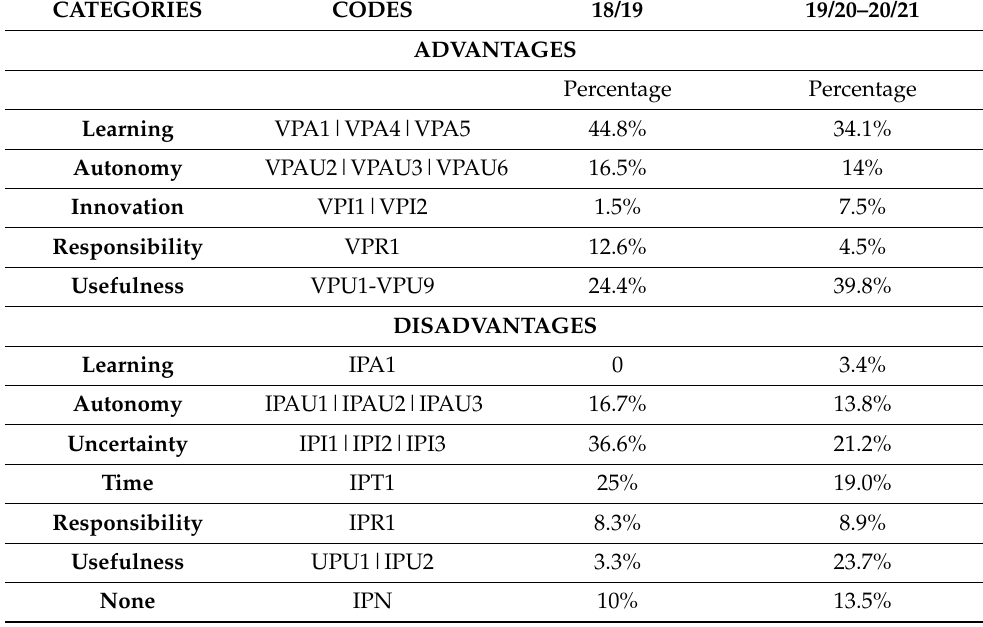
Table 5. Categories, codes and percentages of the opinions of the students about the digital portfolio before and during the COVID-19